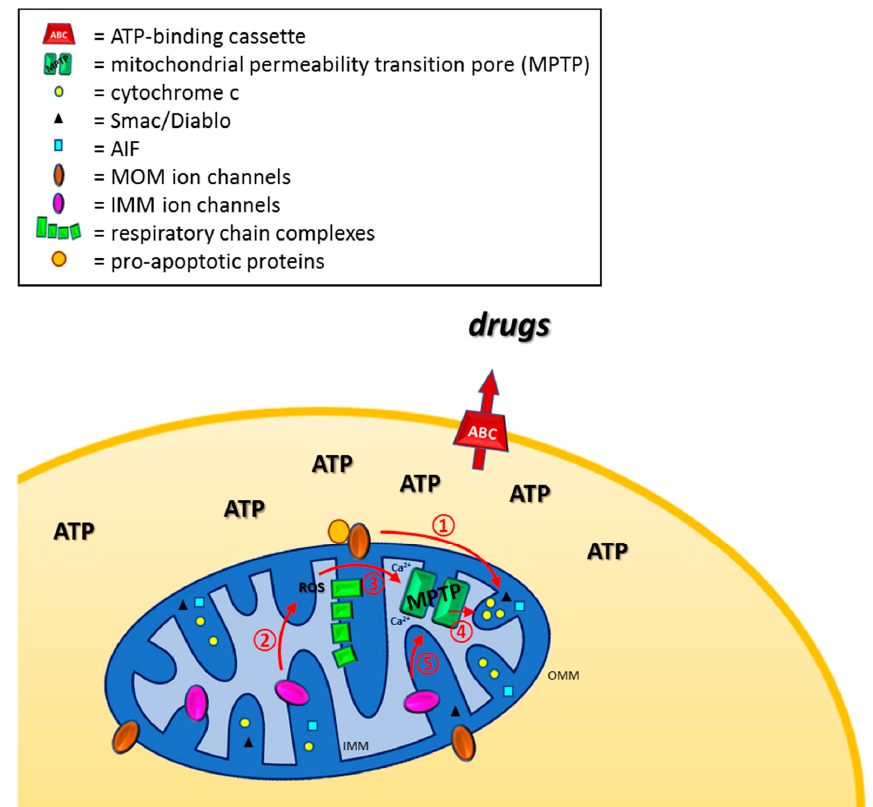
Figure 1. Possible contribution of mitochondrial ion channels to counteracting chemo-resistance. Ion channels and pore-forming proteins of the MOM may directly allow release of cytochrome c and pro-apoptotic proteins from the intermembrane space ① . Channels of the IMM may: 1) decrease efficiency of oxidative phosphorylation (respiratory chain complexes are depicted as green rectangles) ② , thereby reducing ATP production that is necessary for the function of ABC type multidrug resistance pumps at the plasma membrane (depicted as ABC); 2) by modulating oxidative phosphorylation efficiency ② , IMM channels may lead to increased ROS release that in turn triggers opening of MPTP ③ and subsequent release of cytochrome c and other pro-apoptotic factors ④ ; 3) by modulating membrane potential of IMM, different IMM channels may trigger MPTP opening ⑤ . See text for further details.